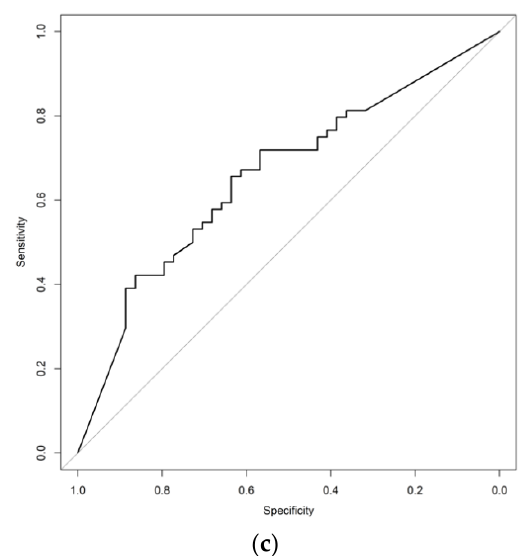
Figure 2. ROC curves representing the sensitivity and specificity of ( a ) relative iCTC reduction (%), ( b ) relative aCTC reduction (%), and ( c ) relative iCTC + aCTC reduction (%) for detecting patients with PD after a single cycle of systemic therapy. Table 2. ROC characteristics